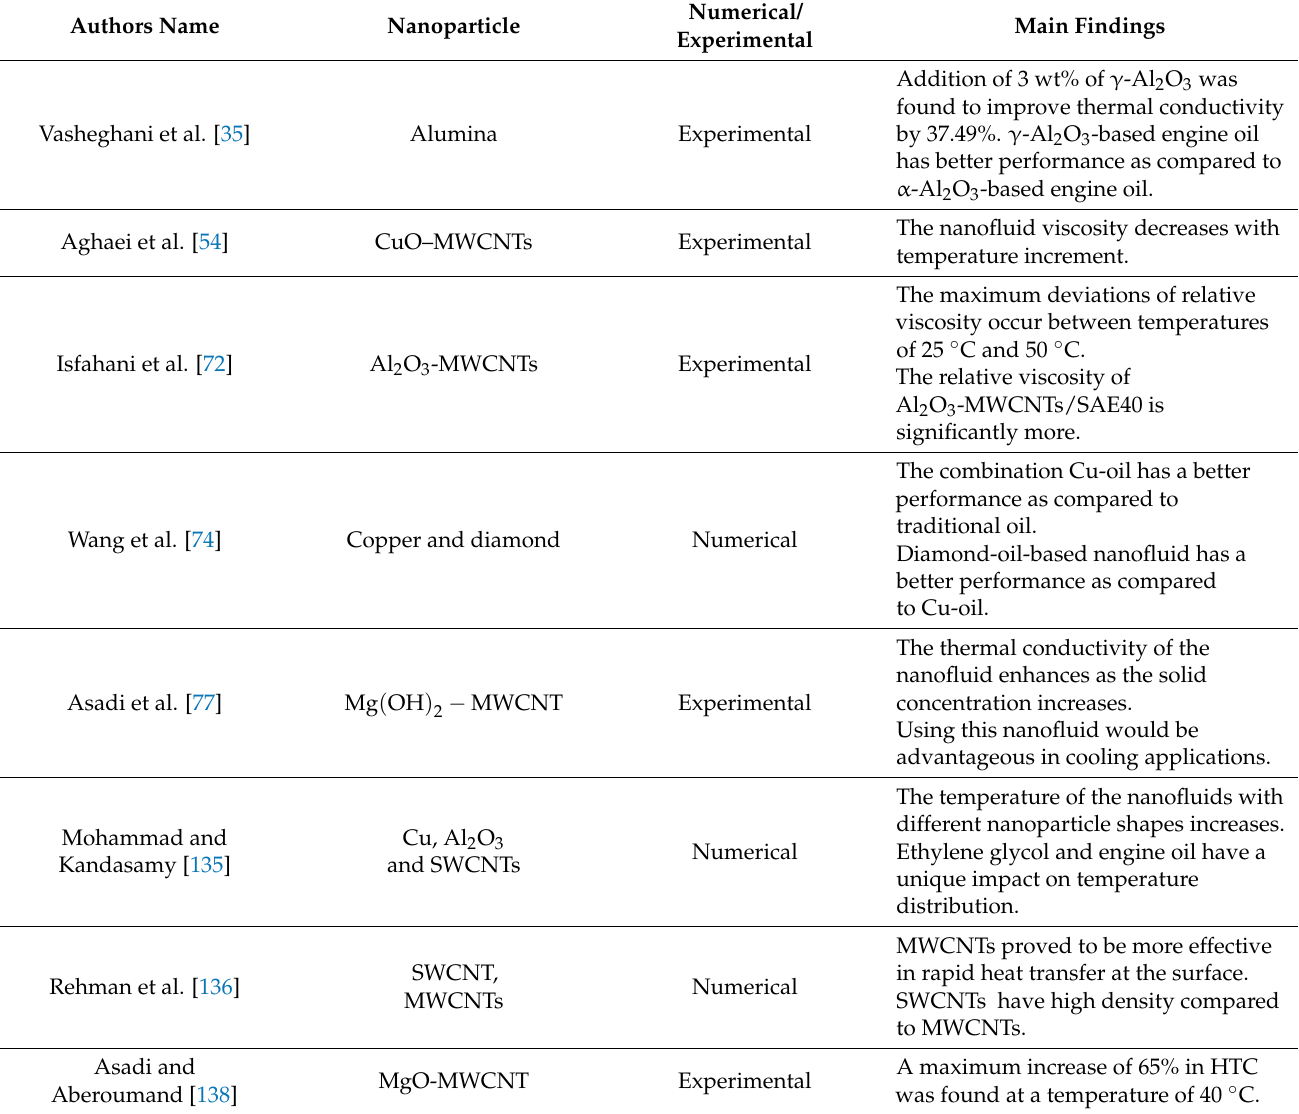
Table 11. Comparison of previous investigations on engine-oil-based